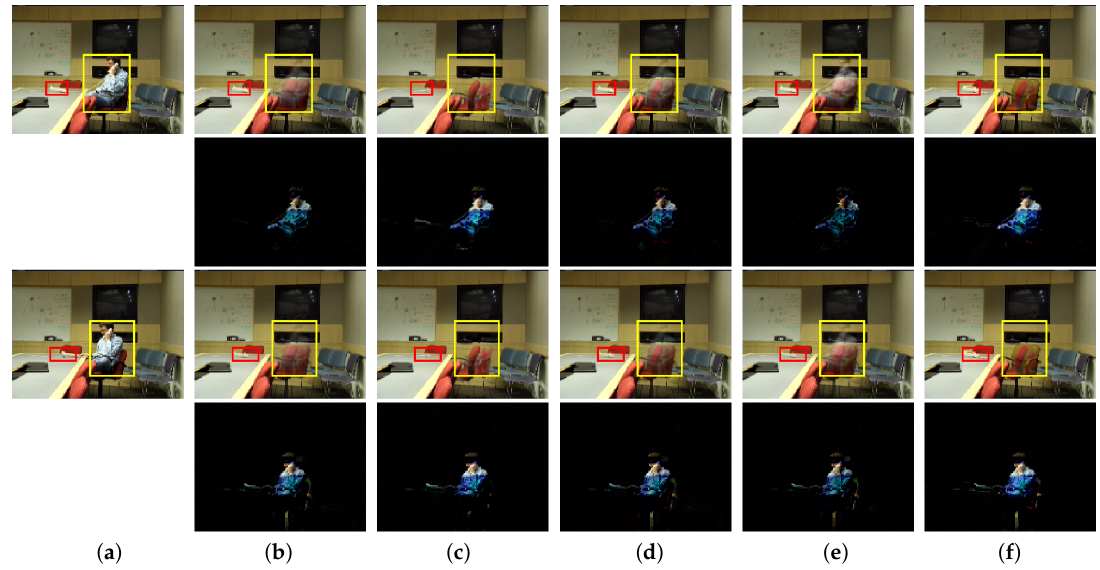
Figure 4. Background modeling: two example frames from MovedObject sequences are shown.